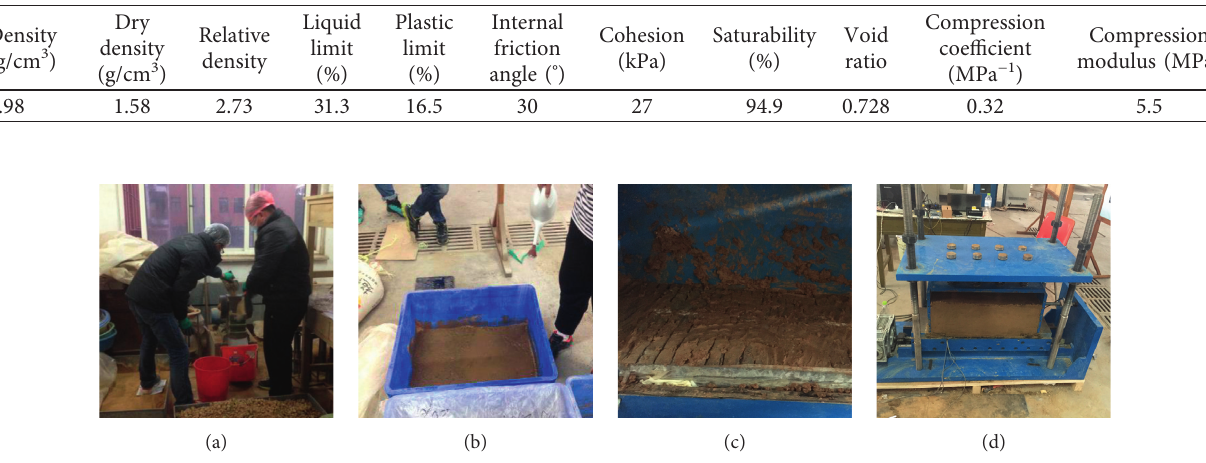
Figure 6: Test preparation. (a) Soil sample grinding. (b) Soil sample preparation. (c) Concrete slab production. (d) Installation.